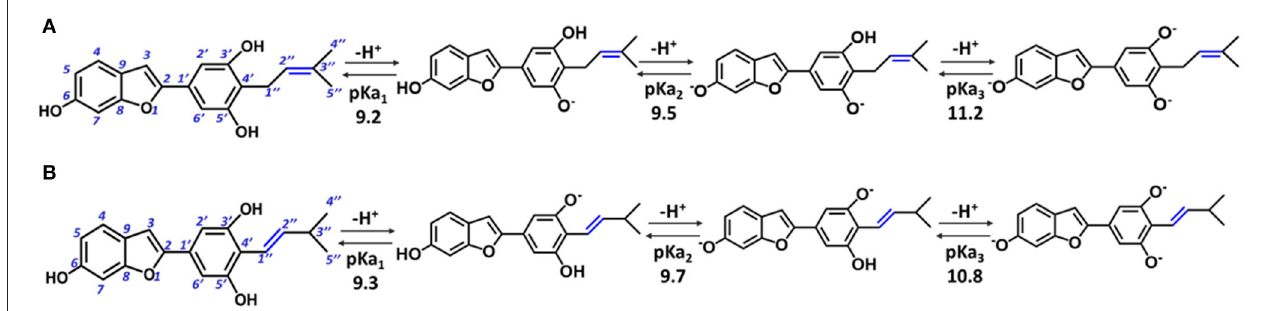
FIGURE 1 | Structure of moracin C and iso -moracin C, and pKa values of the relative deprotonation paths at physiological pH. (A) Moracin C. (B) Iso-moracin